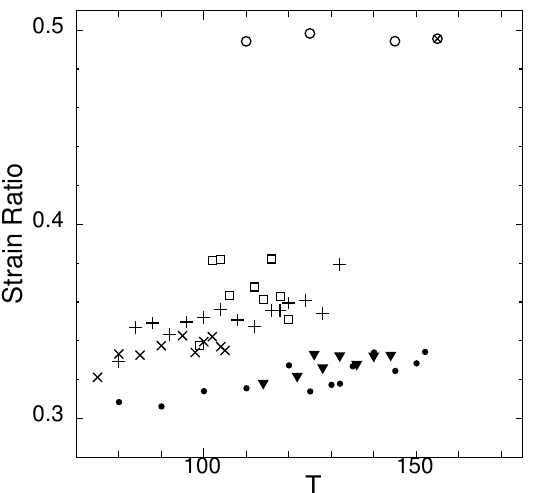
Figure 11. Temperature dependence of strain ratio (cid:101) ⊥ / (cid:101) ∣∣ of states G ( ▼ ), J ( ◻ ), M ( × ), O ( + ), and crystal ( ● ), with supercooled liquid ( ○ ) and thermodynamic equilibrium liquid ( ⊗ ), for system size N = 5376.